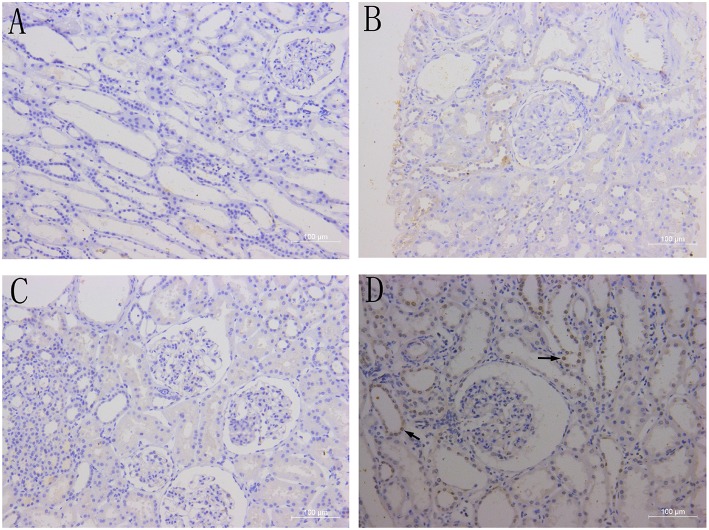
BAFF expression in kidney tissues. Representative images of BAFF staining from healthy controls (A) and patients with drug-induced renal damages (B), stable renal function (C) or acute cellular rejection (D) arrows indicates BAFF-positive staining within the membrane and cytoplasm of renal tubular epithelial cells.